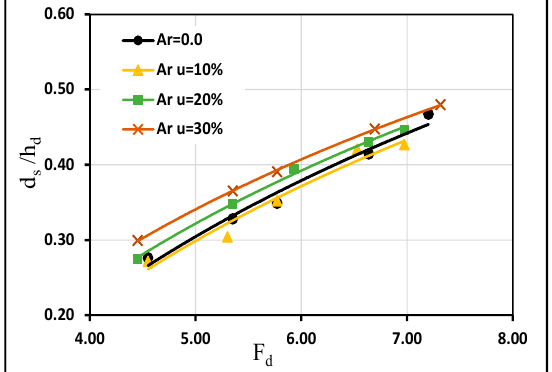
Figure 9. Relationship between (d s / h d ) and (F d ) at S = 1.06 and Ar u = 0%, 10%, 20%, 30% and Ar Figure 9. Relationship between (d s /h d ) and (F d ) at S = 1.06 and Ar u = 0%, 10%, 20%, 30% and Ar d = 0.00. Figure 9. Relationship between (d s /h d ) and (F d ) at S = 1.06 and Ar u = 0%, 10%, 20%, 30% and Ar d = 0.00. Figure 9. Relationship between (d s /h d ) and (F d ) at S = 1.06 and Ar u = 0%, 10%, 20%, 30% and Ar d = 0.00. d = 0.00.